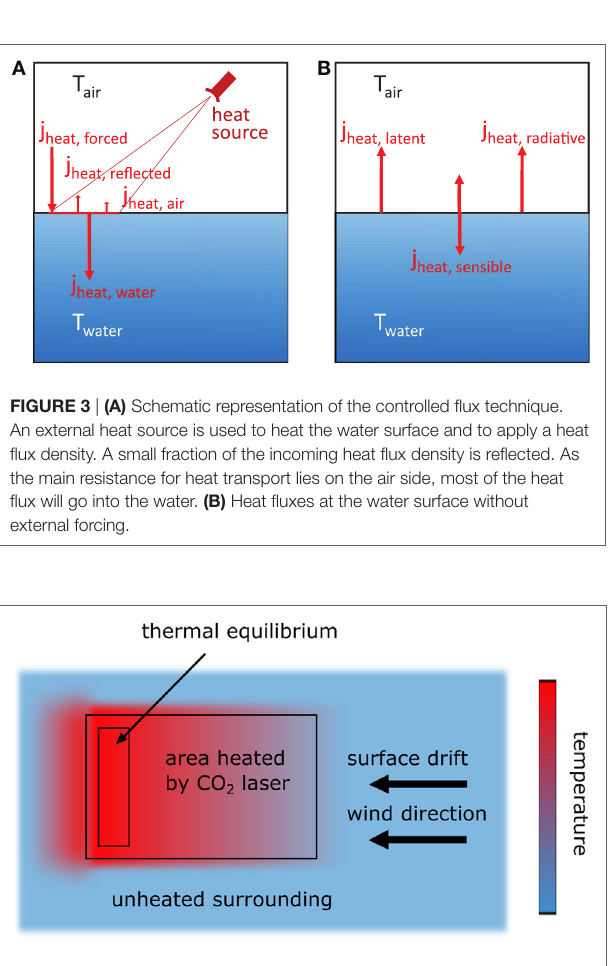
FigURe 4 | Heating process of the water surface seen from above. The water heats up steadily as it flows through the area that is externally